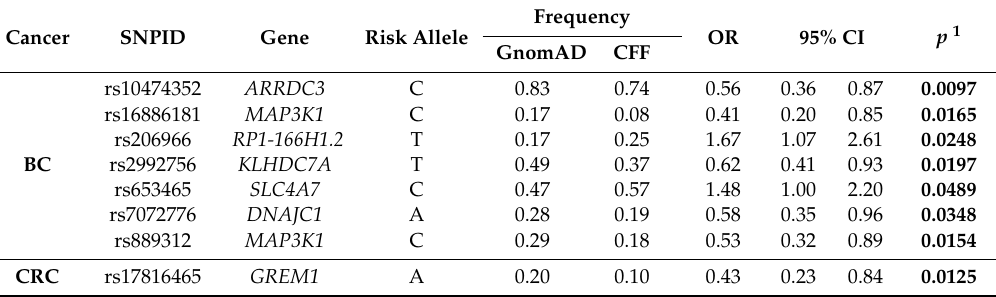
Table 1. Comparison of risk allele frequency between cancer-free families (CFFs) and gnomAD for breast, colorectal, and prostate